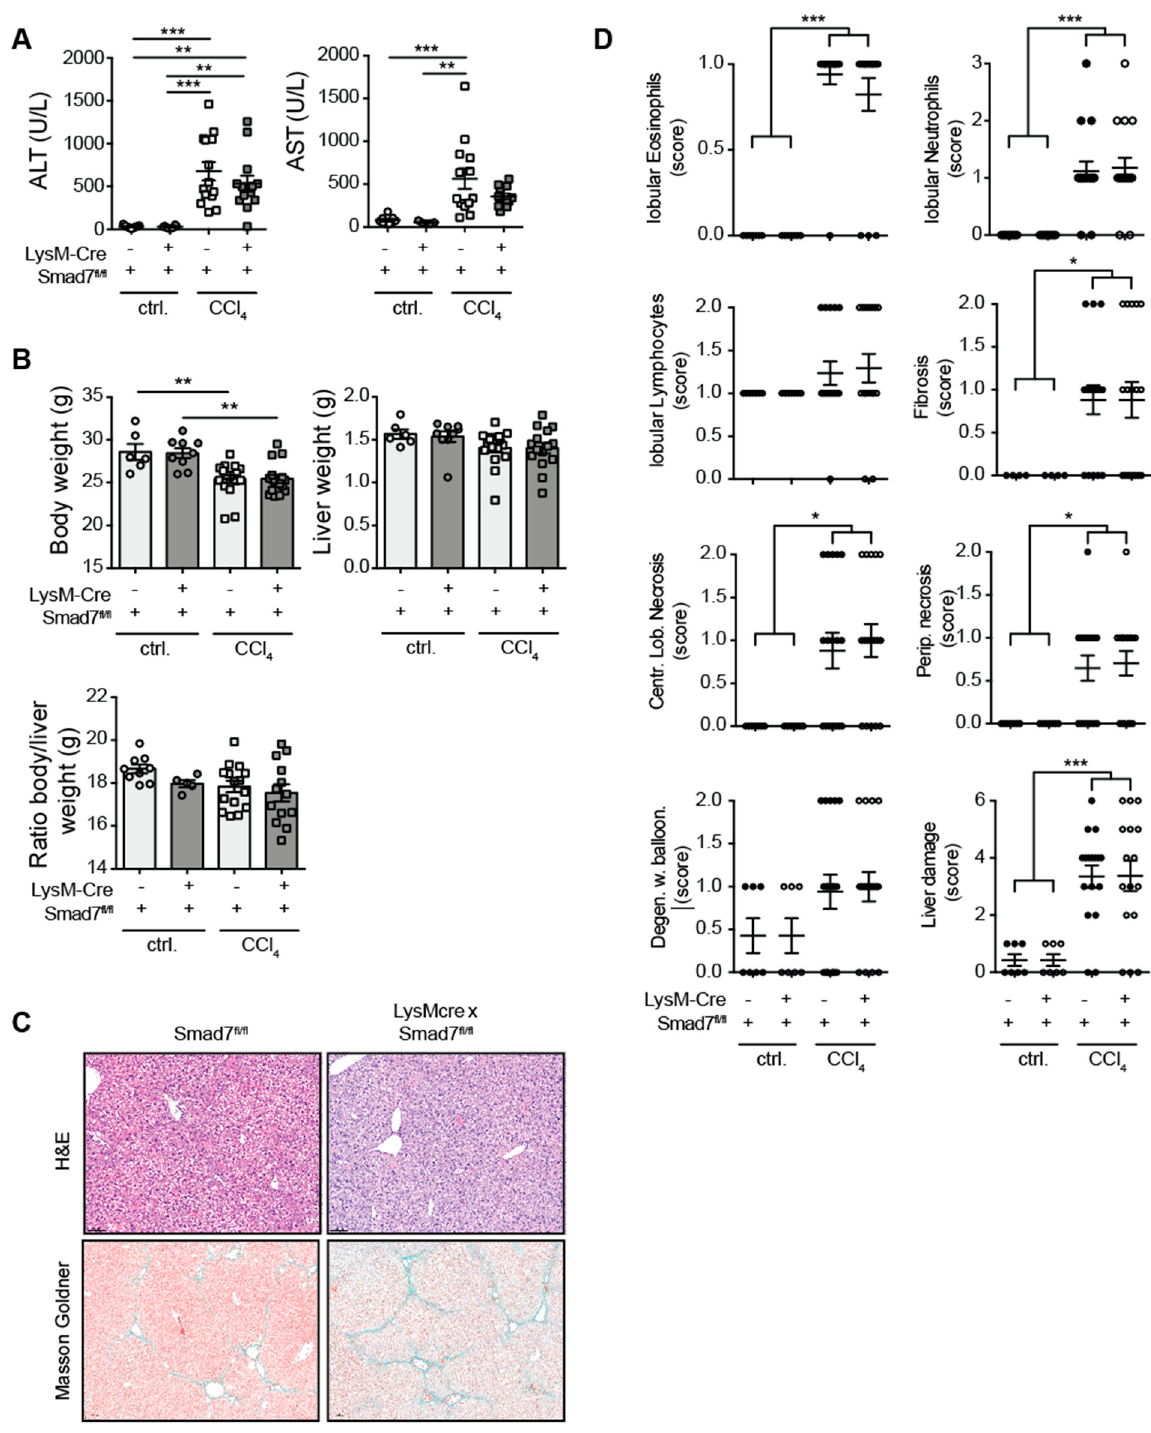
Figure 1. Liver enzymes and histological damage parameters were not changed due to myeloid deletion of Smad7 after chronic CCl 4 application. LysM-Cre pos Smad7 Δ / Δ and Smad7 fl/fl littermates were injected intraperitoneally with CCl 4 in corn oil or corn oil alone (ctrl.) twice a week for 6 wks. Mice were sacrificed 24 h after the last CCl 4 –oil application. ( A ) Serum ALT and AST (U/L). ( B ) Body weight, liver weight and body-to-liver weight ratio of mice at the time of sacrifice. ( C ) Representative H&E and Masson–Goldner staining of livers of CCl 4 -treated Smad7 fl/fl and LysM-Cre pos Smad7 Δ / Δ littermates at 10× magnification as indicated. ( D ) Histological scores of H&E staining in which the liver damage score is a cumulative value out of periportal (Perip.) and centrilobular (Centr. Lob.) necrosis, degeneration with ballooning (Degen. w. balloon.) and fibrosis. Data shown are cumulative data of 5 independent experiments with 3–5 animals per group. Data are displayed as the mean ± SEM. Data were analysed by ANOVA: * p ≤ 0.05, ** p ≤ 0.01, *** p ≤ 0.001.